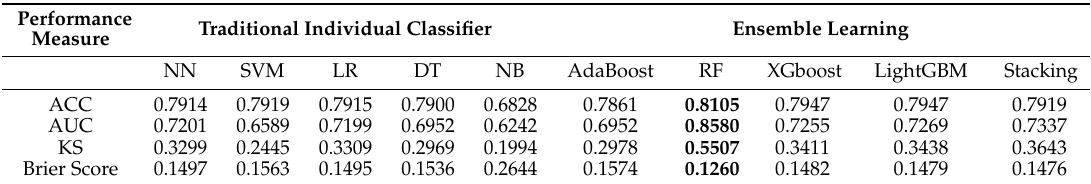
Table 2. Classifier results in terms of 4 measures.